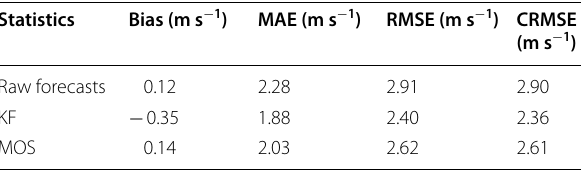
Table 2 The overall performance of the KF and MOS bias corrections for wind speeds sensitive to wind power prediction based on four metrics (bias, MAE, RMSE, and CRMSE) Statistics